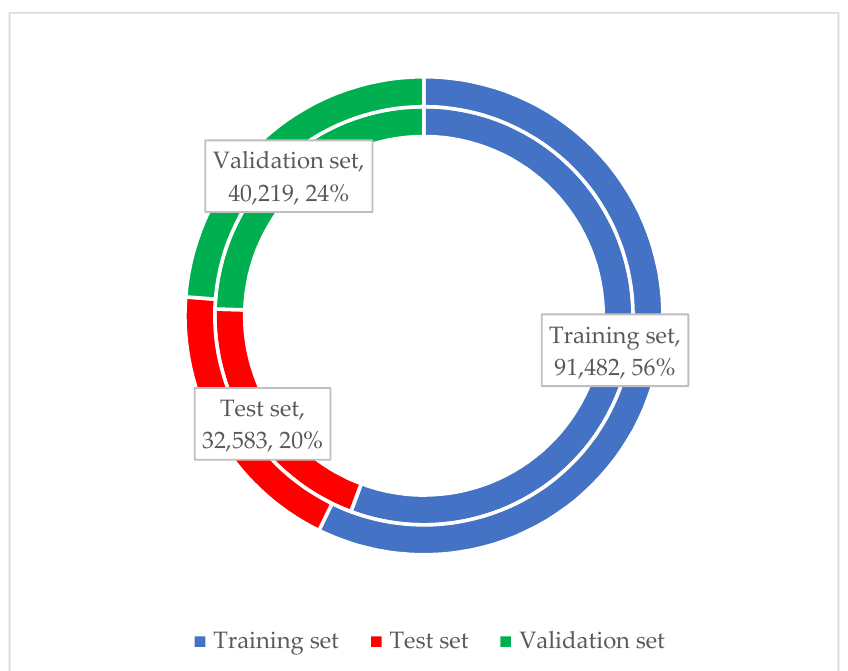
Figure 4. Ratio of training set, test set, and validation set.